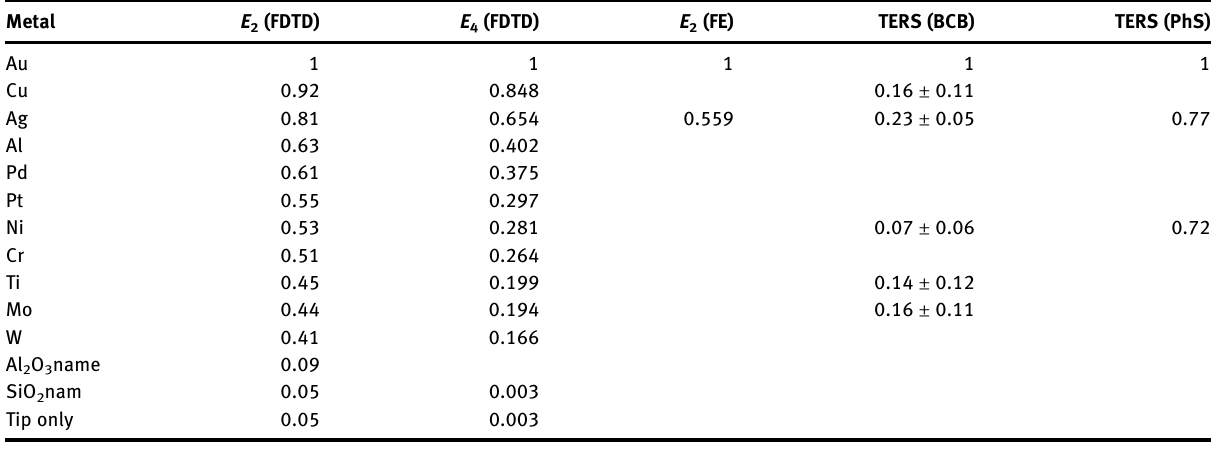
Figure 4: Electric field intensity distribution at the apex of Ag tip at an excitation wavelength of 532 nm for different polarization conditions. The bottom- illumination with a linearly polarized light without (A) and with Au substrate (B). The side-illumination with a linearly polarized light without (C) and with Au substrate (D). The bottom-illumination with a radially polarized light without (E) and with Au substrate (F) [75]. Copyright (2013) Optical Society of